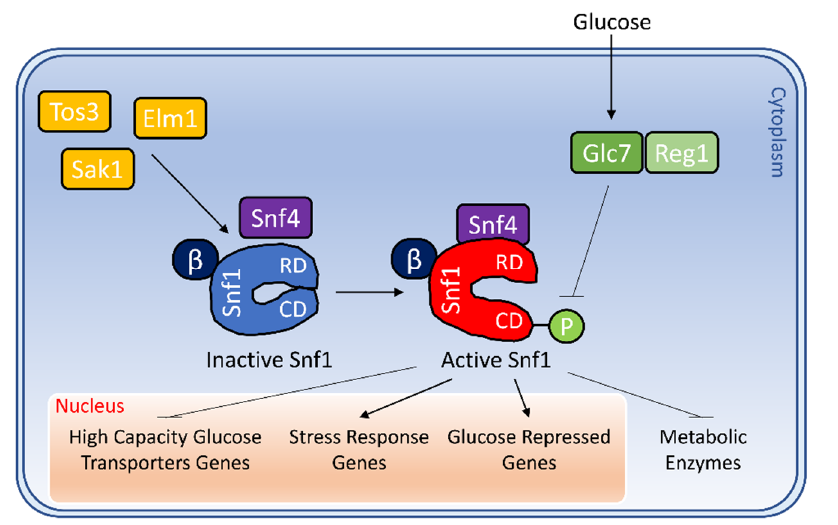
FIGURE 1: Schematization of the activa- tion of Snf1 and its main conventional functions. Snf1 complex is composed by the α subunit Snf1, the ƴ subunit Snf4 and one of three alternative β subunits Gal83, Sip1 or Sip2. Snf1 is phosphorylated on T210 by the upstream kinases Sak1, Tos3 and Elm1, while it is de-phosphorylated by the phosphatase complex Glc7/Reg1. When active, Snf1 phosphorylates transcription factors which regulate the ex- pression of genes involved in glucose transport, stress response and glucose re- pression. In addition, Snf1 directly phos- phorylates some metabolic enzymes. See text for